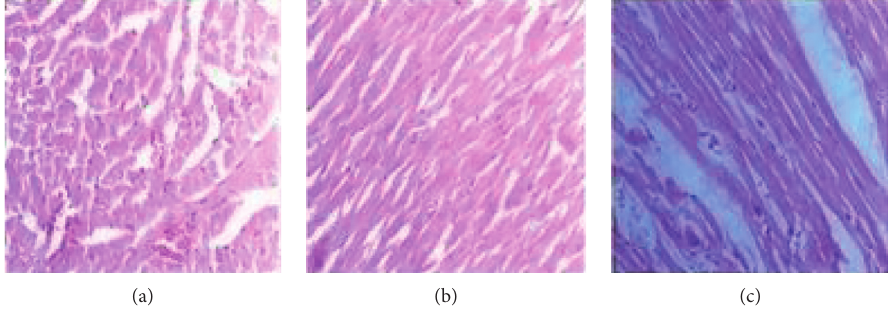
Figure 7: Photomicrographs of the heart sections of rat. (a) Control. (b) A. malaccensis 300mg/kg. (c) A. malaccensis 2000mg/kg. Scale bar, 10 µ m.